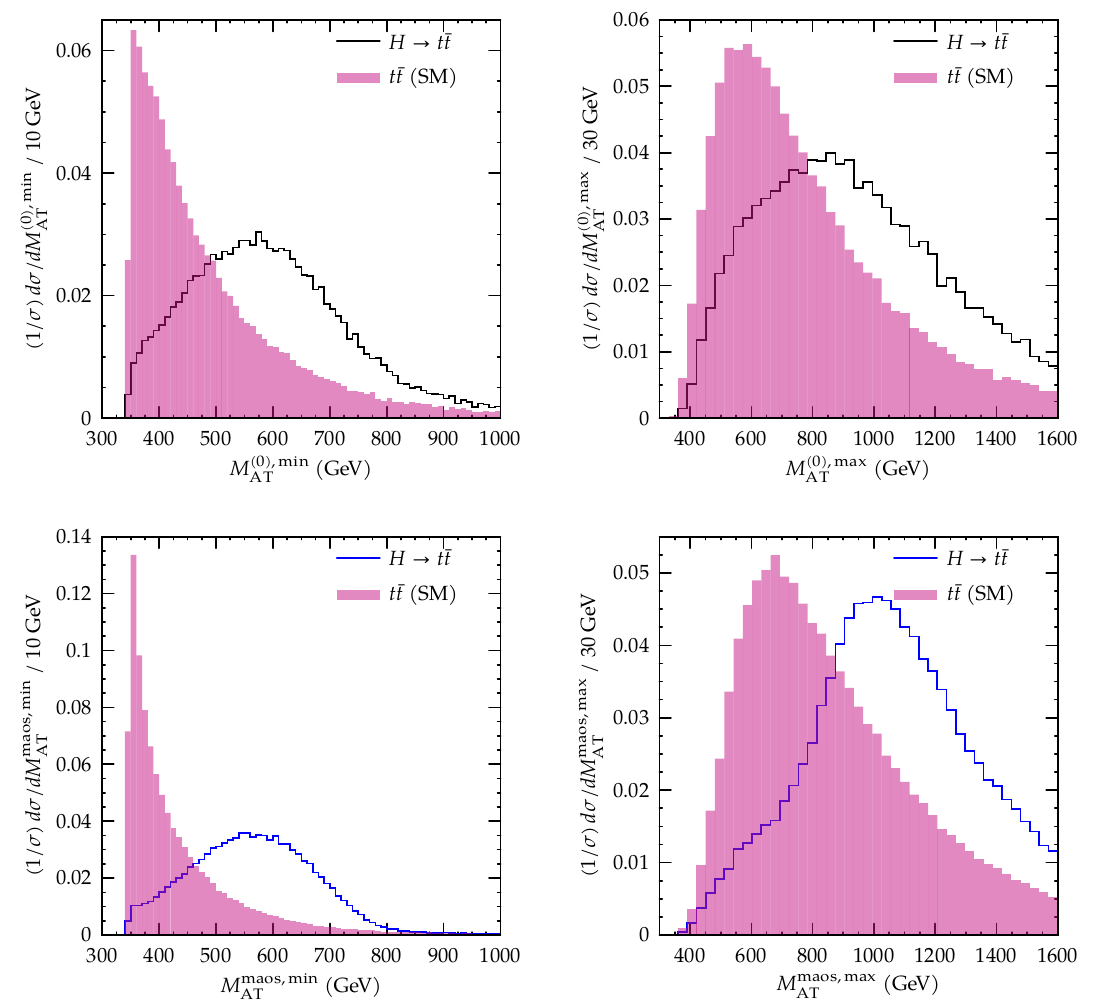
Figure 6 . The M (0) (upper) and M maos (lower) distributions for detector-level events. We have AT AT applied the basic selection